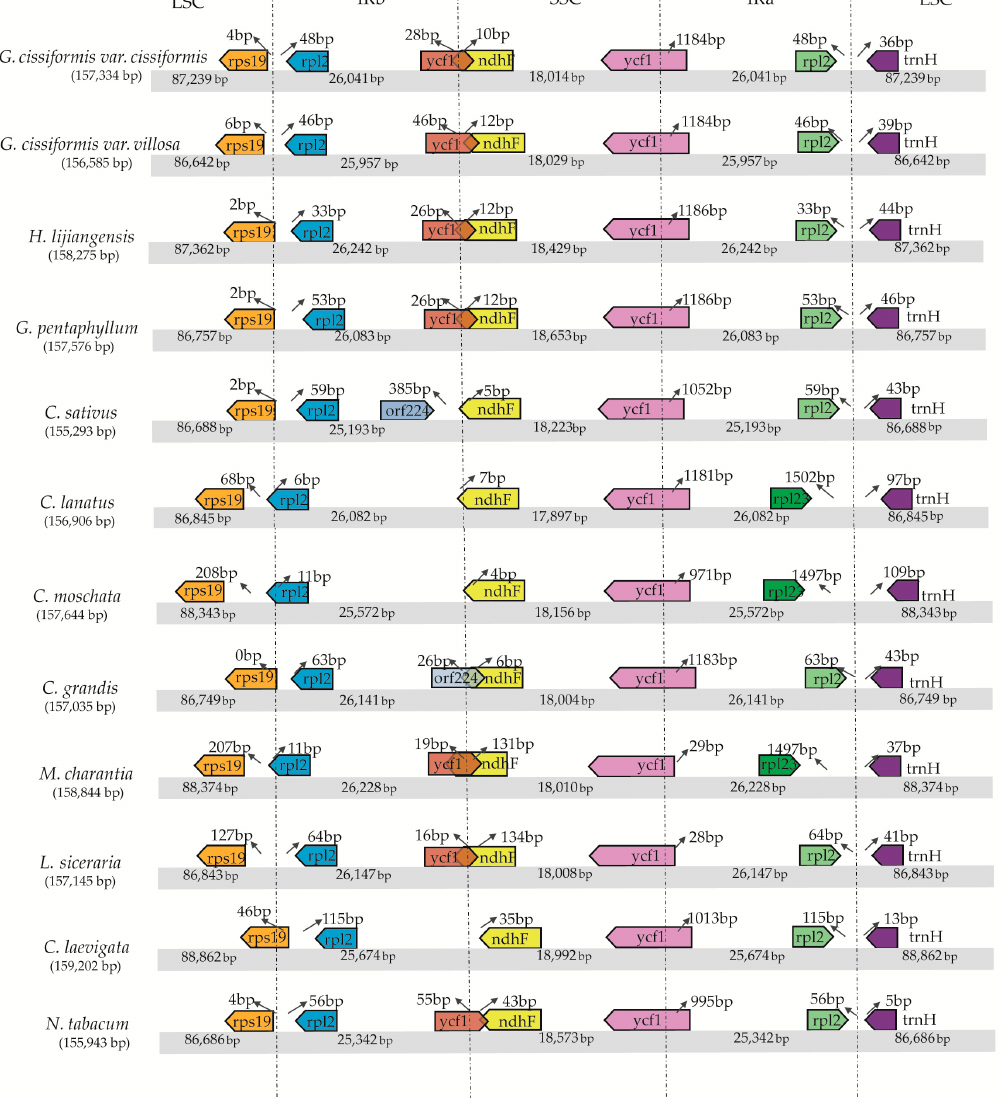
Figure 3. Comparison of the LSC, IR, and SSC border regions among the 10 Cucurbitaceae chloroplast genomes. Number above the gene features means the distance between the ends of genes and the borders sites. These features are not to scale.